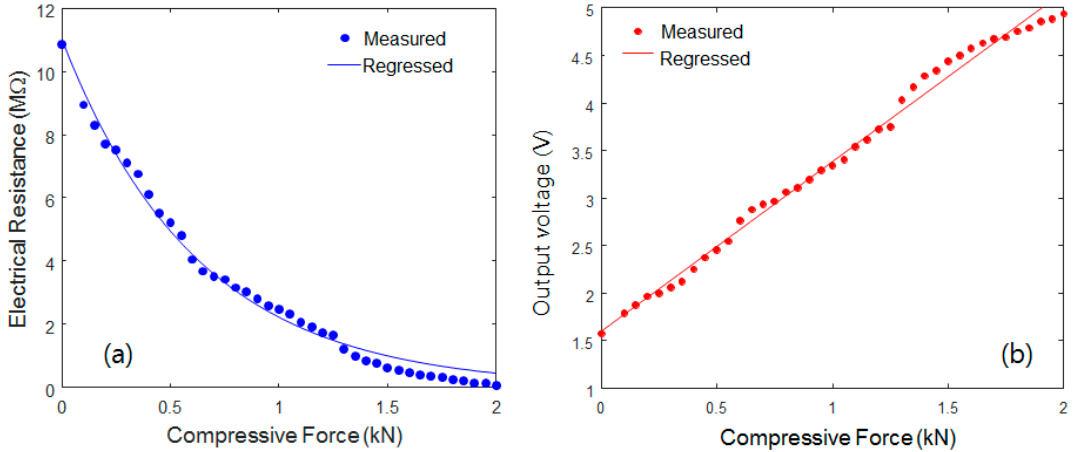
Figure 7. Static piezoresistive response to a step input. ( a ) Electrical resistance vs. compressive force and ( b ) output voltage vs. compressive force.